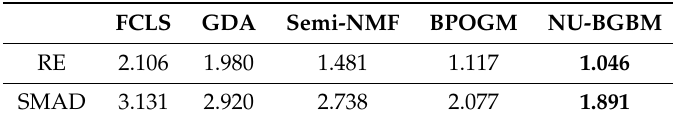
Figure 6. RSS maps of FCLS for the selected real Cuprite HSI, and the difference RSS maps between FCLS and GDA, semi-NMF, BPOGM, and NU-BGBM respectively. Table 2. Comparison of REs ( × 10 − 2 ) and SMADs ( × 10 − 2 ) of different methods using extracted endmembers for the selected Cuprite real